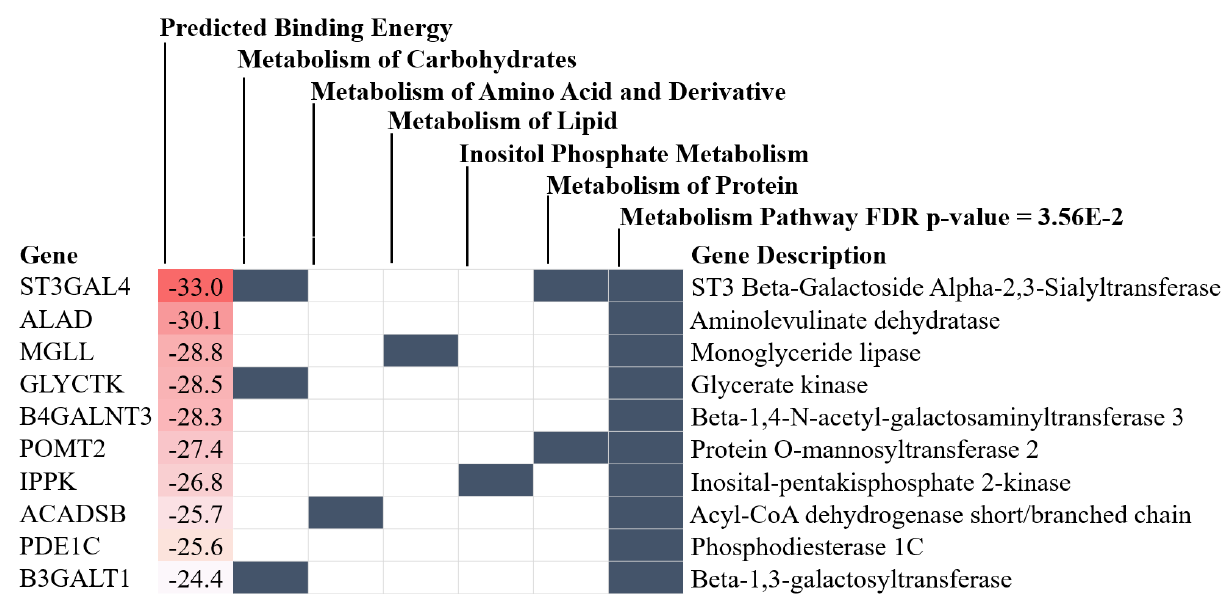
Figure 6. The figure shows binding energy of miR370-3p to the possible target in the metabolic pathway (Reactome analysis).